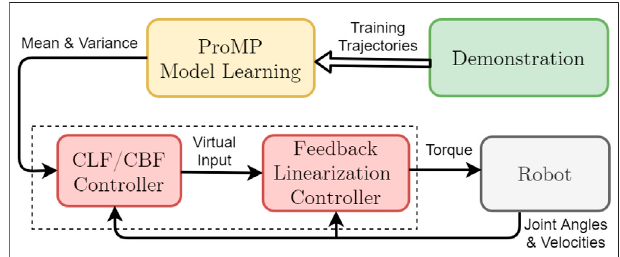
FIGURE 2 | The overall structure of the proposed